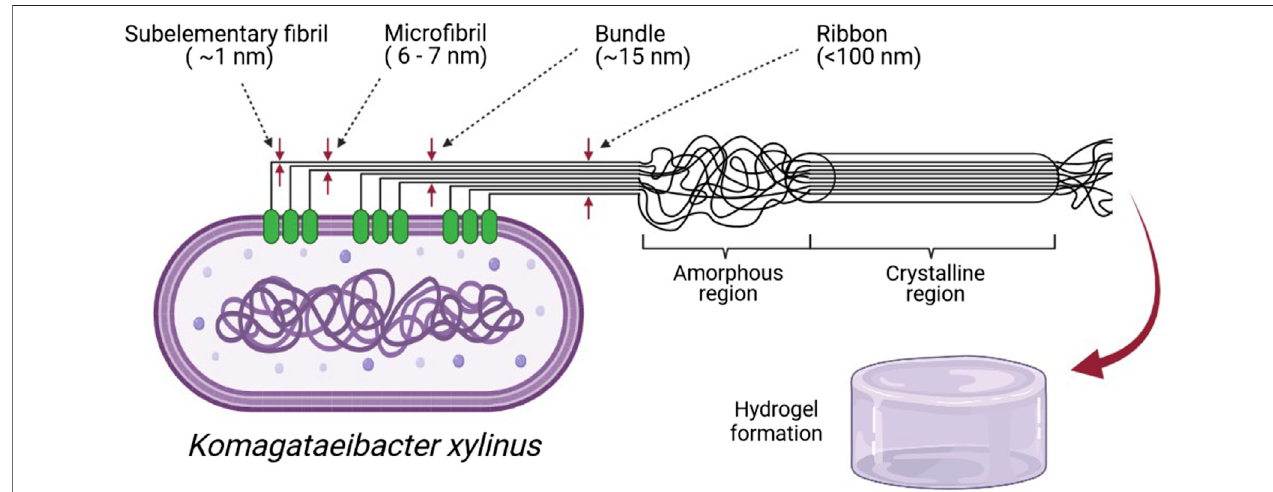
FIGURE6| Bacterialcellulose isproduced bycellulose synthases found ingroups inthe cellwall and (Leeet al., 2014).Cellulose ispulled outside thecell and sub- elementary fi brilisformed.Duringcellmovement,extractedcelluloseconnectandcreatemicro fi brils,bundles,andribbons.BNC,besideshighpurity,ischaracterizedby ahighcrystallineregion(80 – 90%)(Leeetal.,2014),apartwithhighstackedpolysaccharidechains. Komagateibacter duringstationarycultureproduceBNCinaformof hydrogel (created in BioRender.com).